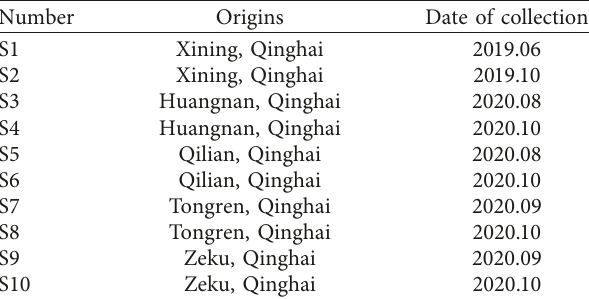
Table 1: The source information of the